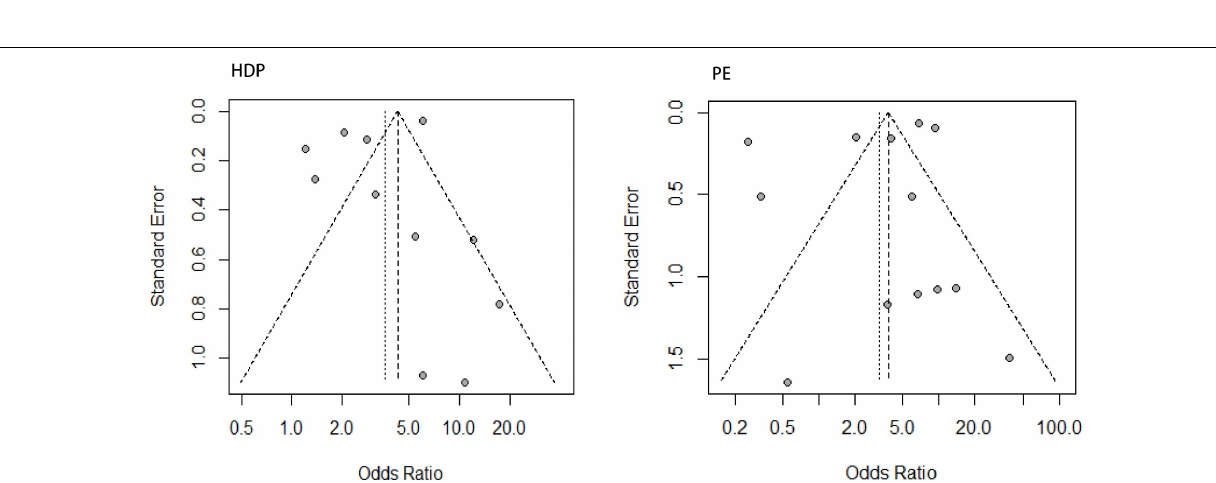
FIGURE 3 | Forest plots of the risk of developing chronic hypertension in the adjusted group. (A) Forest plots of the risk of developing chronic hypertension in the HDP-adjusted group; (B) forest plots of the risk of developing chronic hypertension in the HDP-unadjusted group; (C) forest plots of the risk of developing chronic hypertension in the PE-adjusted group.